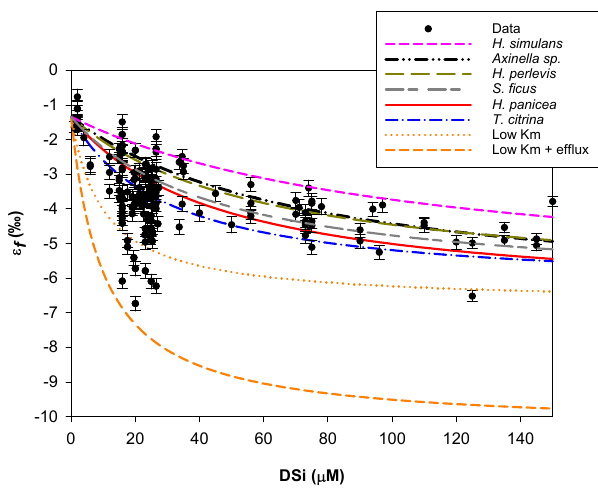
Figure 6. Michaelis–Menten kinetic model of Si isotopic fraction- ation (Eq. 2) for six parameterisations (see Table 2). Black circles are all previously published and JC094 data. Sponge species from top to bottom are as follows. Pink: ε f from Haliclona simulans ki- netic parameters (López-Acosta et al., 2018); black: ε f from Ax- inella sp. (Maldonado et al., 2011); green: ε f from Hymeniacidon perlevis (López-Acosta et al., 2016); grey: ε f from Suberites fi- cus (López-Acosta et al., 2018); red: ε f from Halichondria panicea (Reincke and Barthel, 1997); blue: ε f from Tethya citrina (López- Acosta et al., 2016). The following curves are experimental tests. Orange: V max , p of López-Acosta et al. (2016) T. citrina sp. and K m (10µM), with ε E as 1.39 (dotted) or 5‰